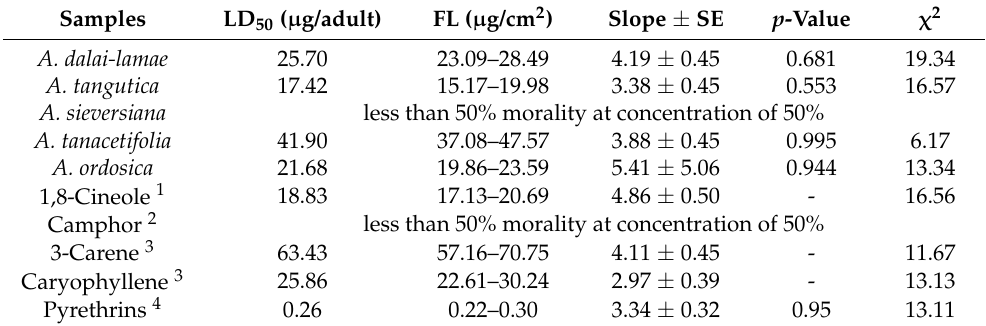
Table 4. Contact toxicities of the essential oils from five Artemisia species and major compounds against T. castaneum